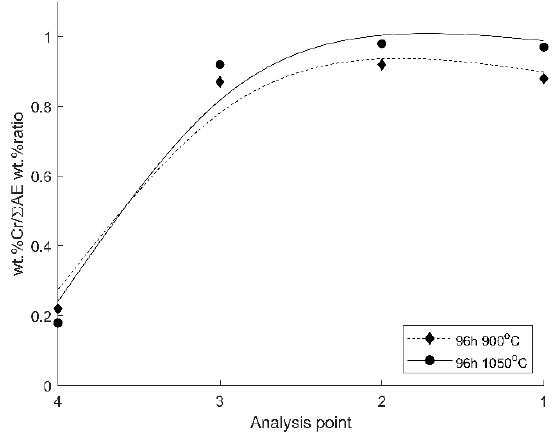
Figure 5. The wt% Cr / Σ AE wt% ratio in the four analyzed microareas.